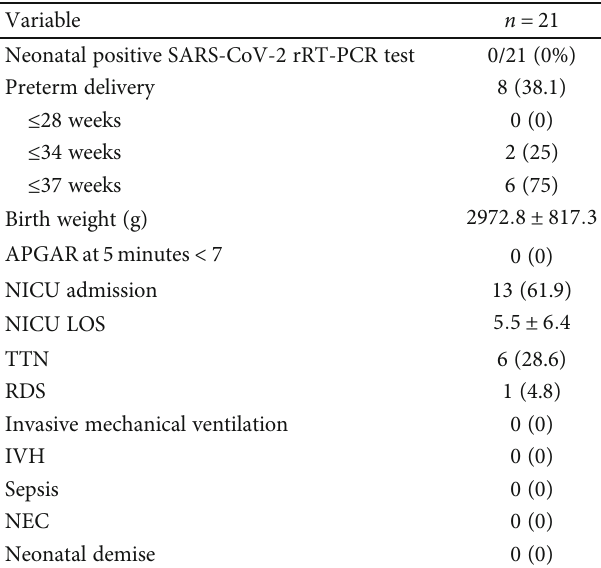
Table 3: Neonatal